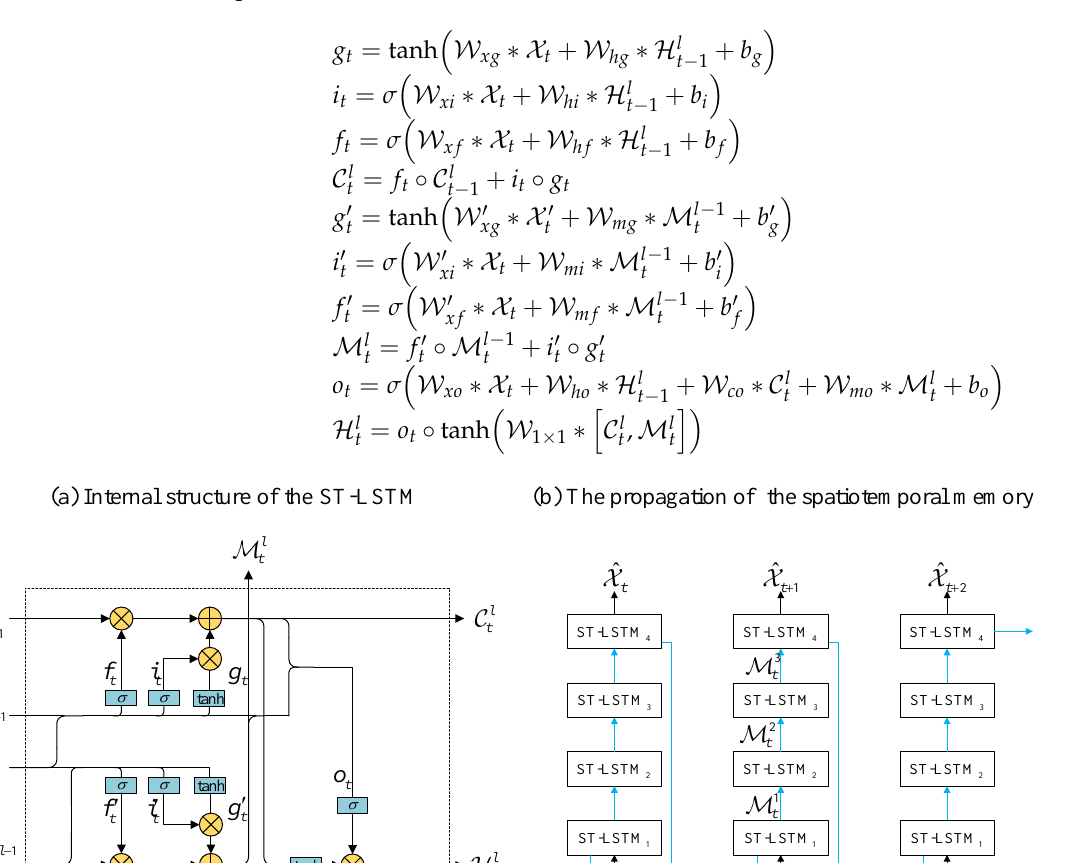
motion trajectories in spatiotemporal